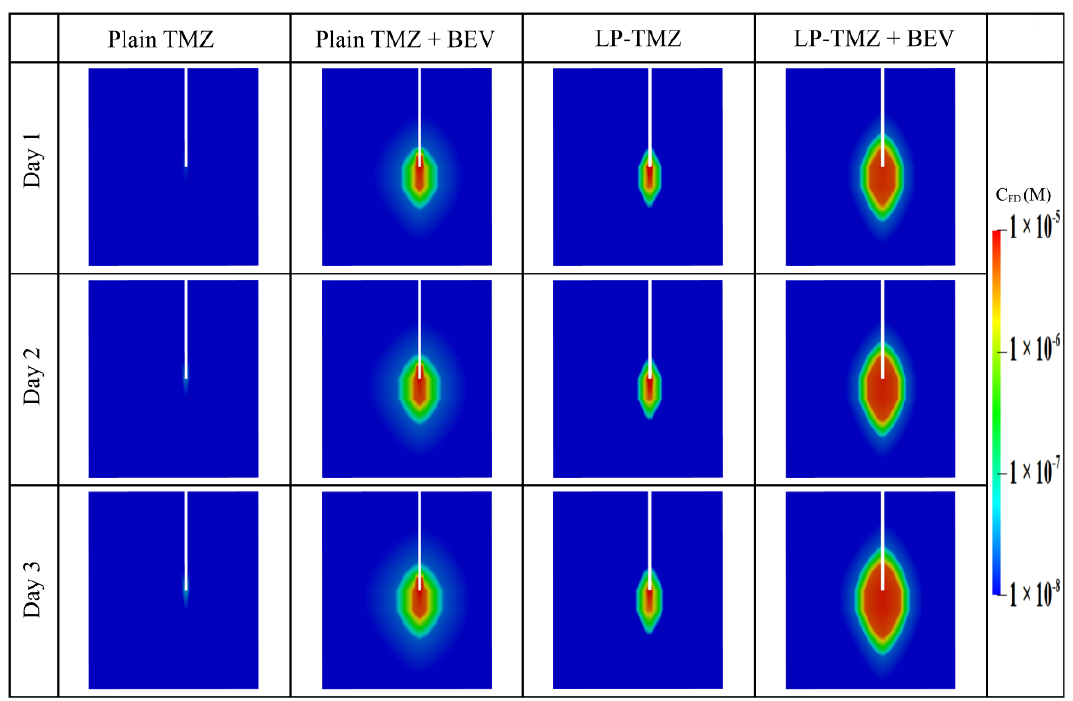
Figure A3. Spatial distribution of released free temozolomide at different time points.